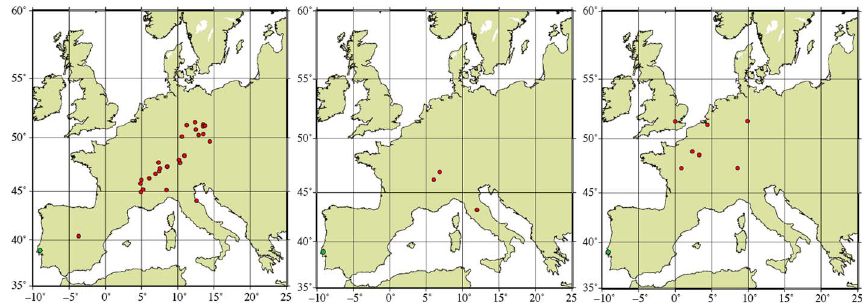
Fig. 1. European locations where aurora was recorded on (a) 6, (b) 7, and (c) 8 March 1582 according to Hattori et al. (2019) (red dots) and this work (green dots) (modi fi ed from Hattori et